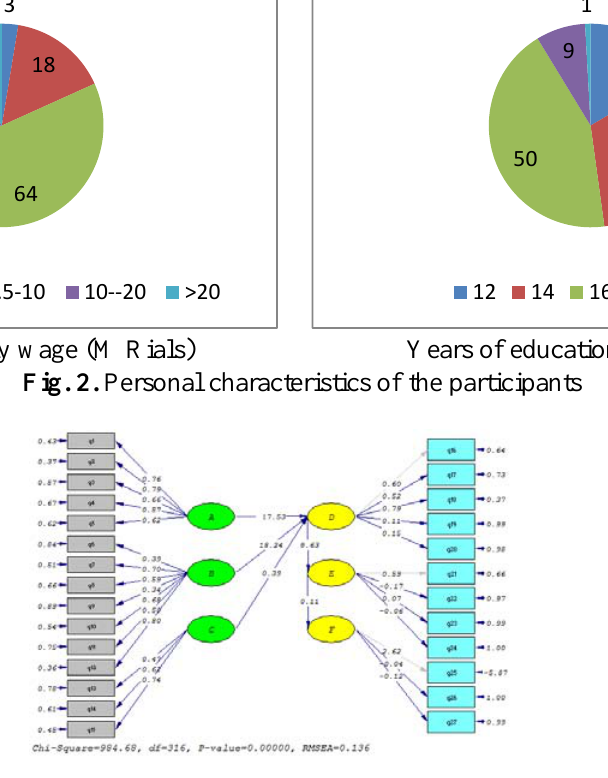
Fig. 3. Model estimation and the path coefficients between